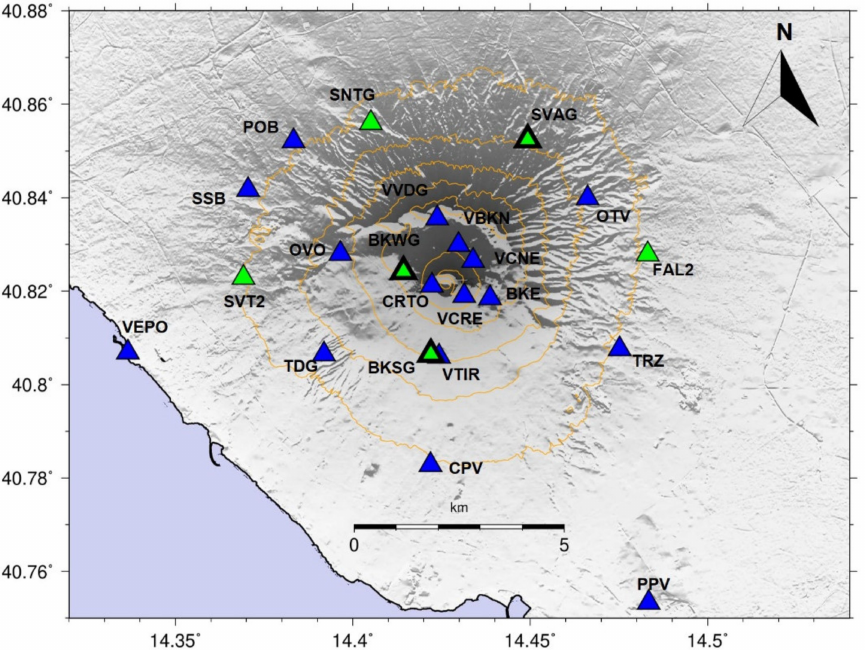
Figure 1. The seismic monitoring network operating on Mt. Vesuvius during the last years. The green triangles indicate the position of stand-alone seismic stations, while the blue symbols show the position of permanent network stations. The green symbols with a ticker border (BKWG, BKSG and SVAG) are the stations used in this